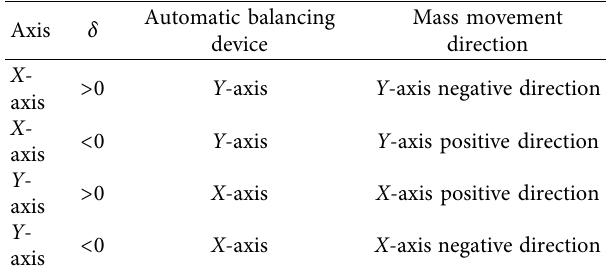
Table 1: Relationship between error attitude angle and mass moving direction.